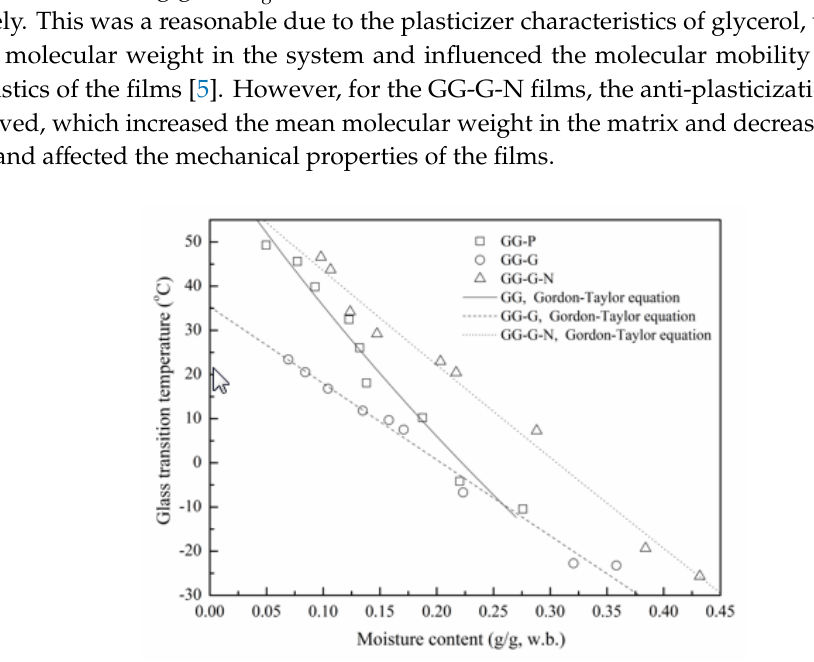
Figure 4. E ff ect of moisture content on the glass transition temperature of GG-based Figure 4. Effect of moisture content on the glass transition temperature of GG ‐ based films.